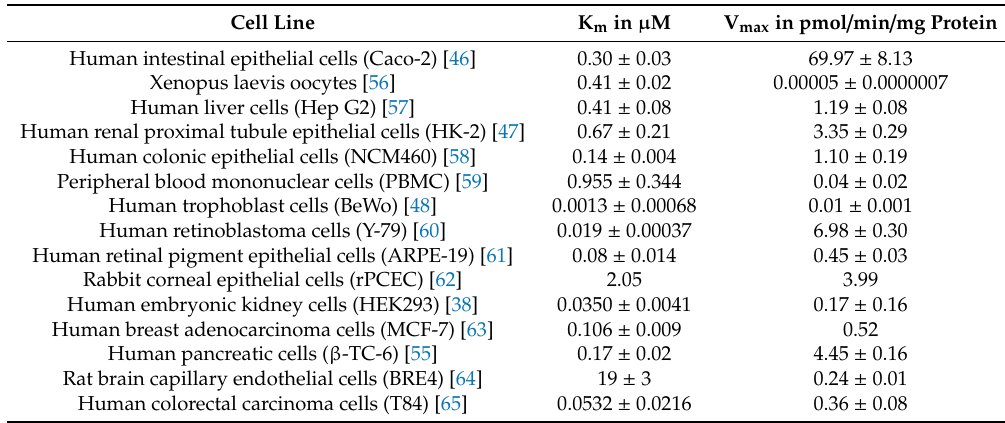
Table 1. Summary of riboflavin uptake kinetics in di ff erent cell